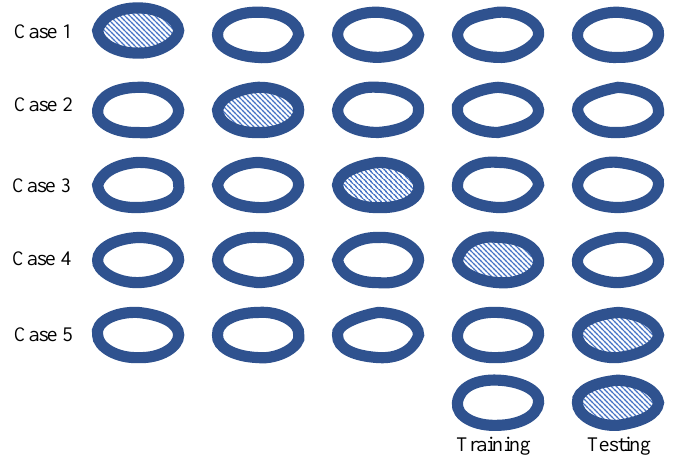
Figure 6. Graphical representation of 5-fold cross-validation